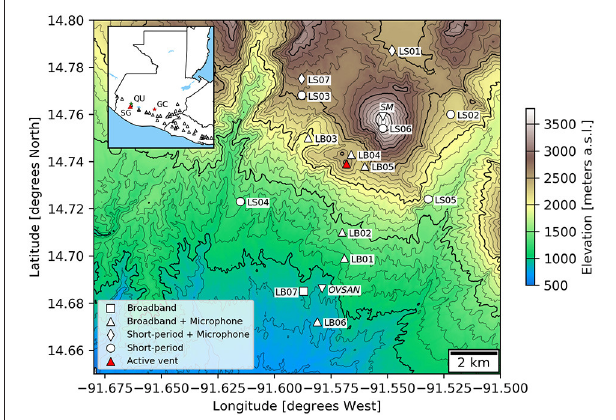
FIGURE 1 | Map of the Santiaguito dome complex with the locations of deployed seismic and acoustic stations in the area. Red triangle marks the location of the active El Caliente vent. The summit of Santa Maria volcano summit (SM) and the old Observatorio Volcan Santiaguito (OVSAN) building are marked with inverted triangles (The observatory building has since been moved to a more secure location close to station LB06 due to the threat of pyroclastic density currents). Thick and thin contours mark 500 and 100 m intervals in altitude, respectively. Inset: Map of Guatemala with the location of Santiaguito (SG, red triangle), Guatemala City (GC, red star) and Quetzaltenango (QU, green star) marked. Also plotted are the locations of other Holocene volcanoes along the Central American volcanic arc (black